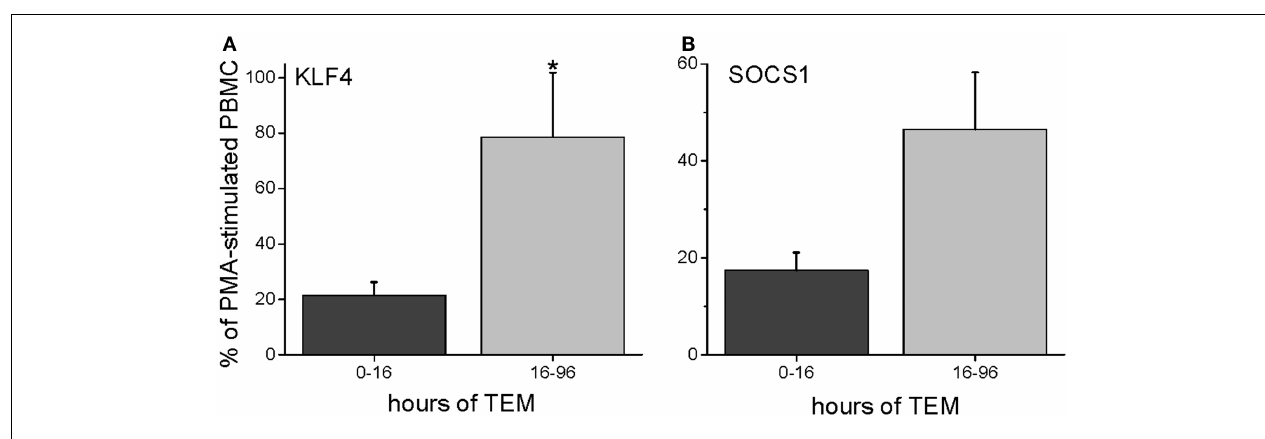
FIGURE 5 | Human PBMC transmigrated for 0–16 or 16–96h were expanded with mitogens (PMA and calcium ionomycin) and harvested for RNA .The gene expression levels were expressed as a (B) ( n = 3 donors in duplicate).